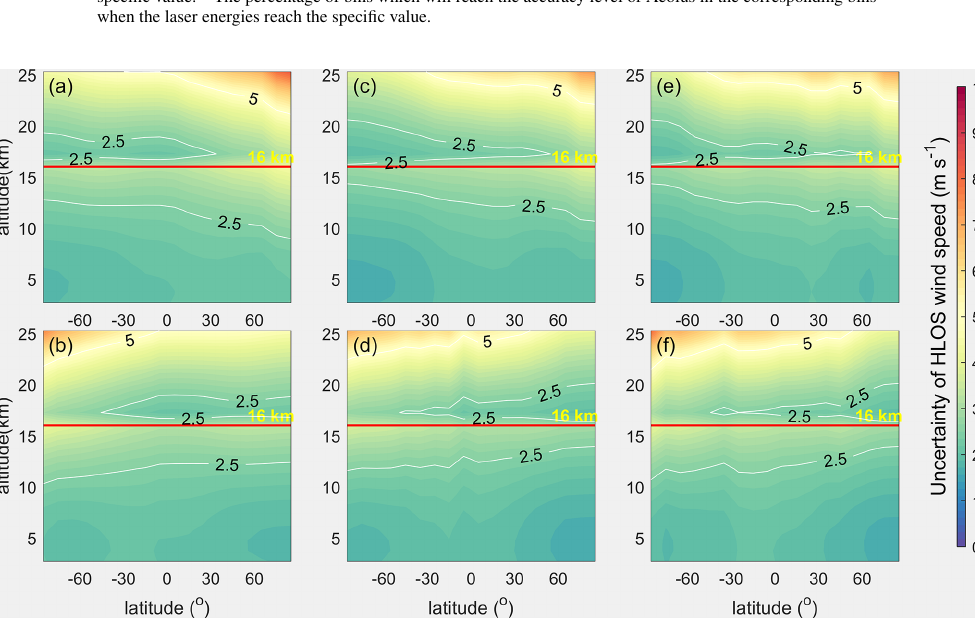
Figure 8. The zonal distributions of the wind observation uncertainties of the three spaceborne DWLs with the laser energy of 60mJ for Aeolus and with a laser energy of 70mJ for the two new Aeolus-type spaceborne DWLs. The arrangement of the subgraphs corresponds to that of Fig.